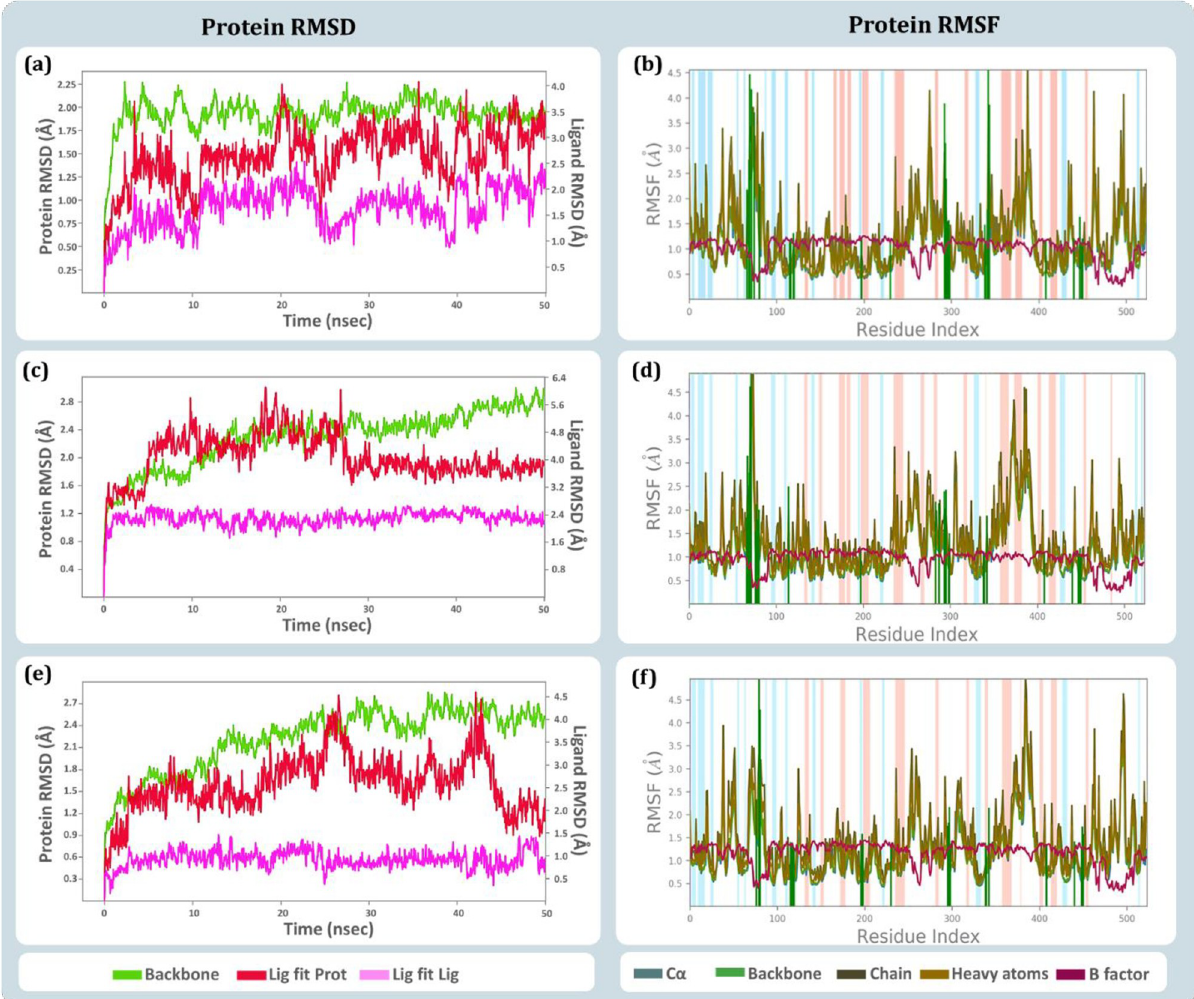
Fig 8. RMSD and RMSF profile obtained on performing 50 ns MD simulation of (a) RMSD of BChE-curcumin complex (b) RMSF of BChE1-curcumin complex (c) RMSD of BChE-donepezil complex (d) RMSF of BChE1-donepezil complex (e) RMSD of BChE-rivastigmine complex, and (f) RMSF of BChE-rivastigmine